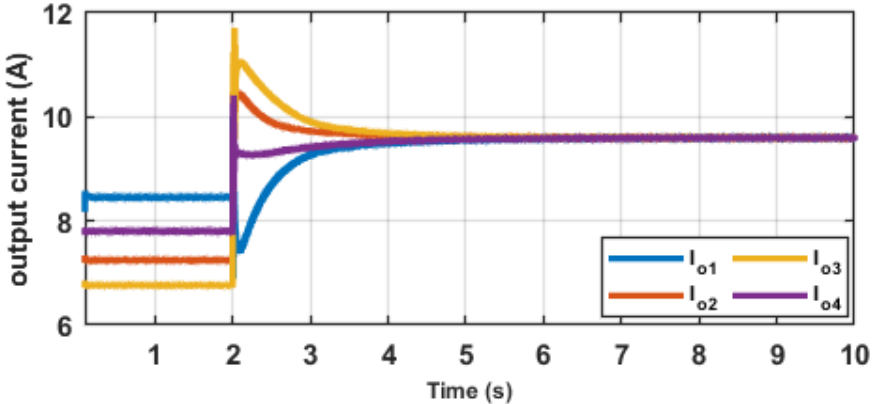
Figure 9. Output currents of DGs using Topology